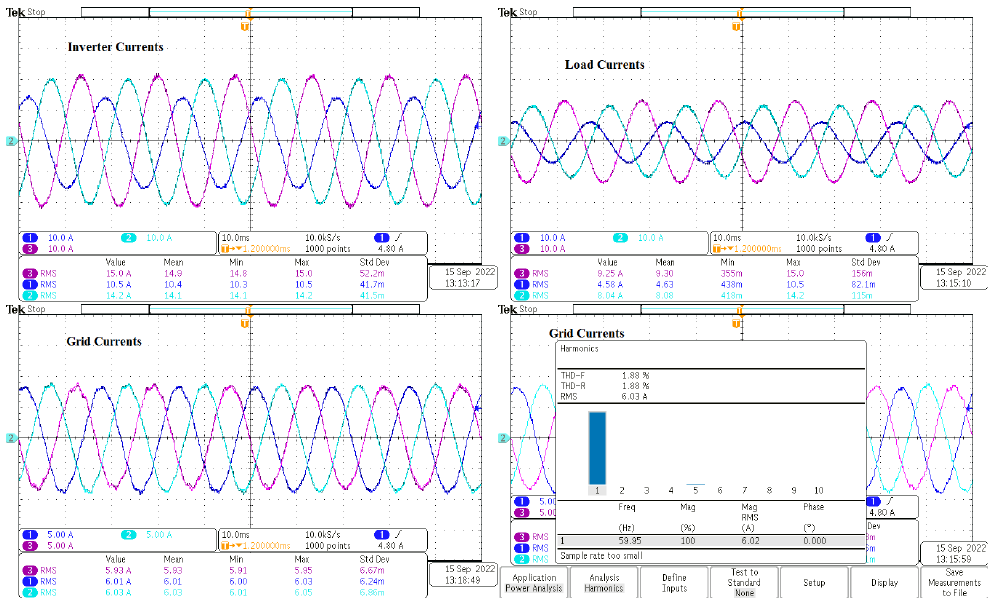
Figure 27. Hardware results using Tektronix MDO3024 oscilloscope for real power = 2 kW and reactive power = 0 var under unbalanced grid inductances.